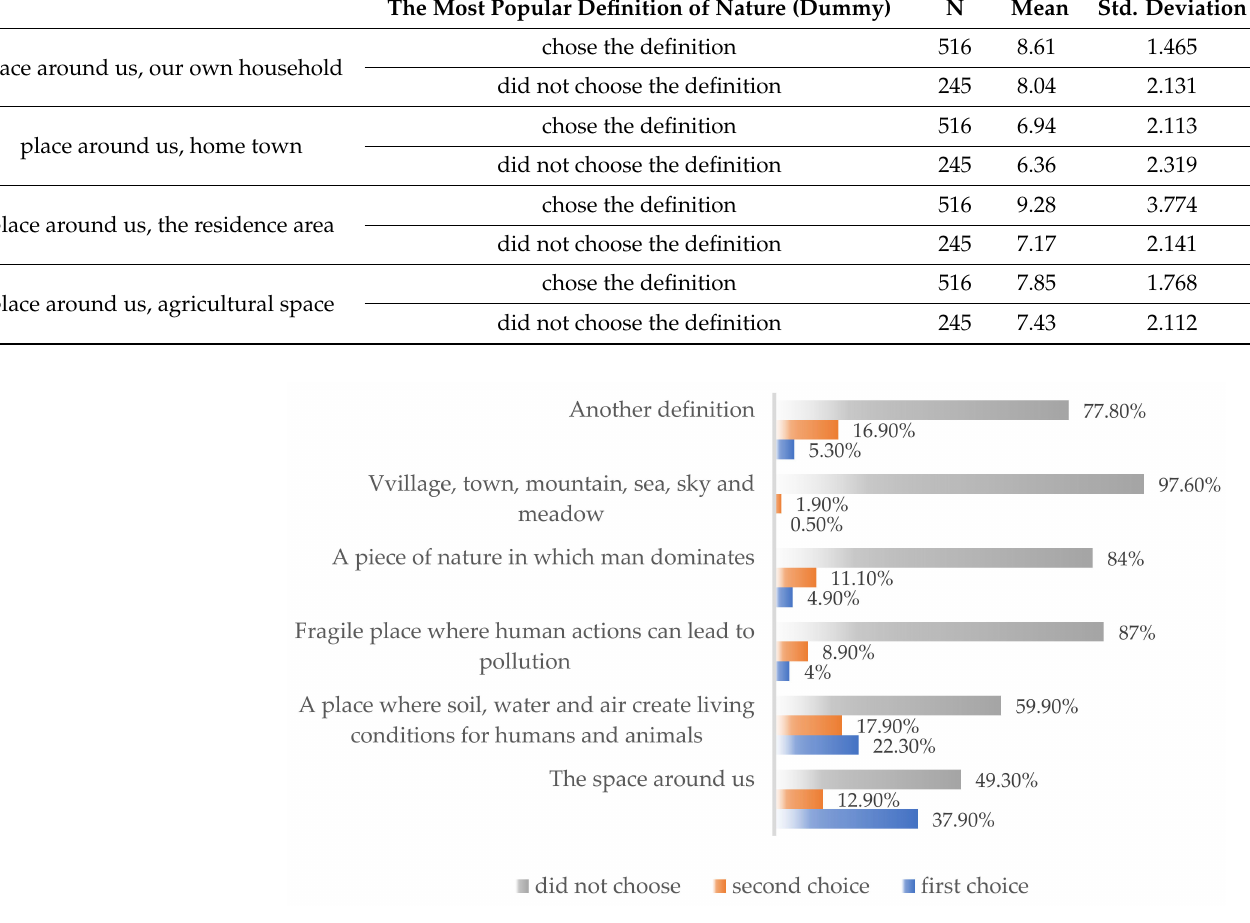
Figure 5. People’s perception of the term of